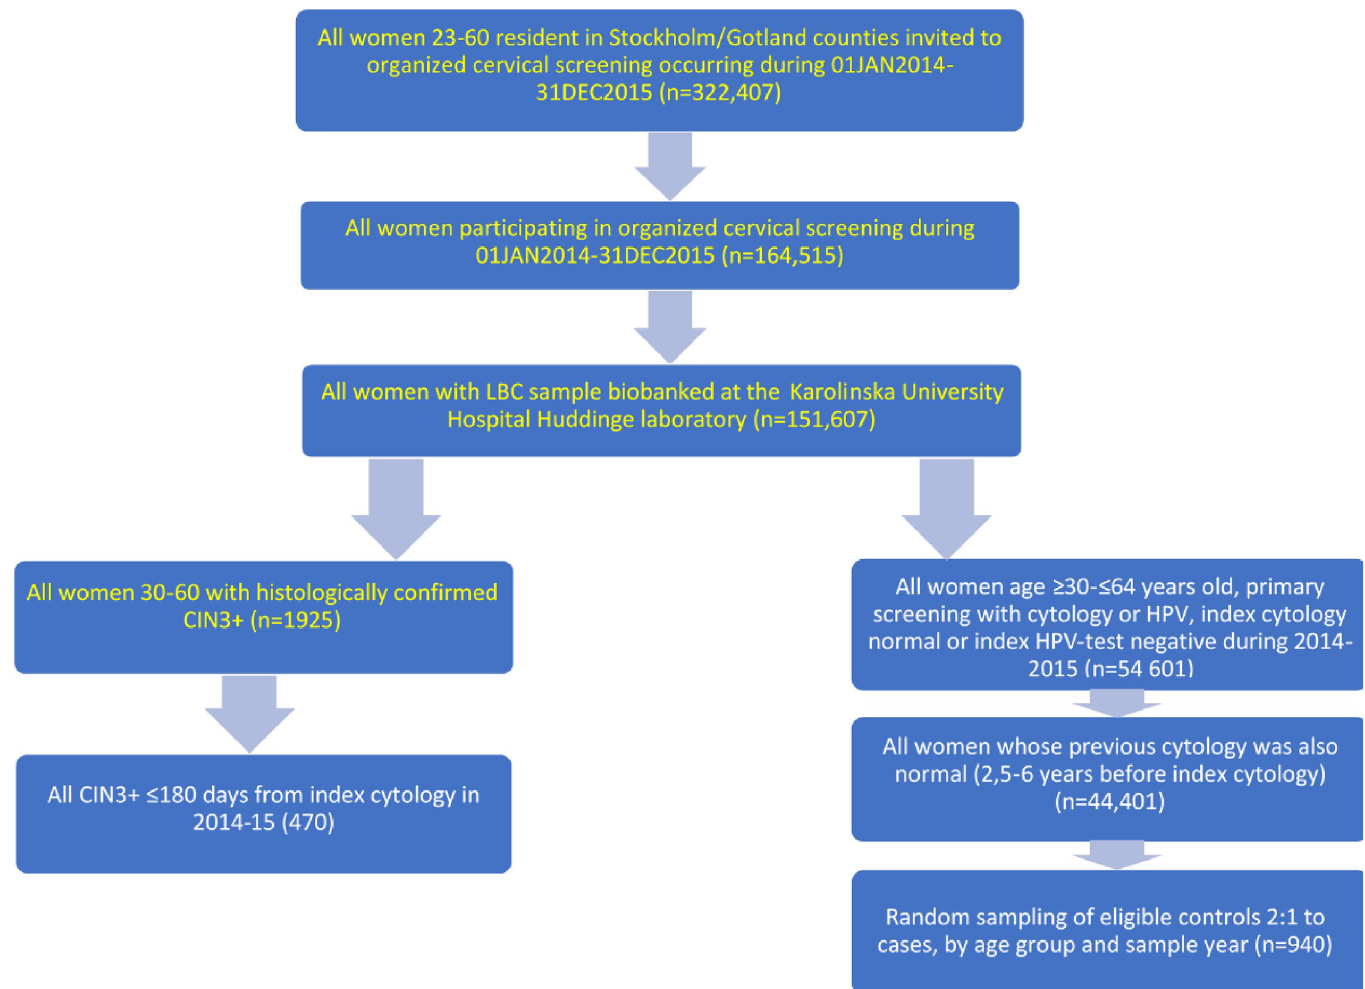
Fig 1. Flow chart of the study participants. LBC = liquid-based cytology; CIN3+ = cervical intraepithelial neoplasia grade 3 or worse (including adenocarcinoma in situ/ AIS and invasive cervical cancer).